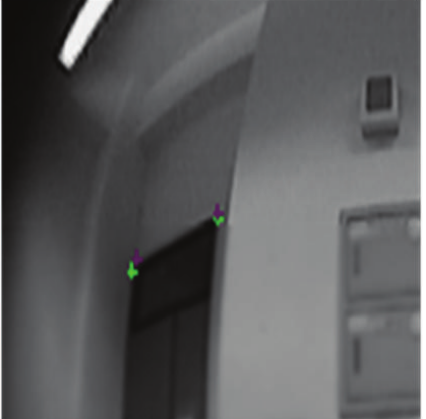
Figure 6: The predicted pixel locations of the targets are denoted by the green crosses and estimated by using the sensor model. The pixel locations of the red crosses are the corresponding target pixel locations and detected by applying cross-correlation